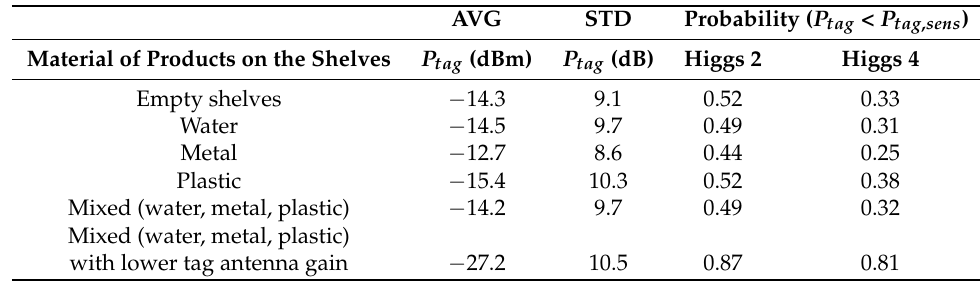
Table 4. Statistical parameters of P tag at each receiver position in a 2D receiver grid for all examined scenarios.